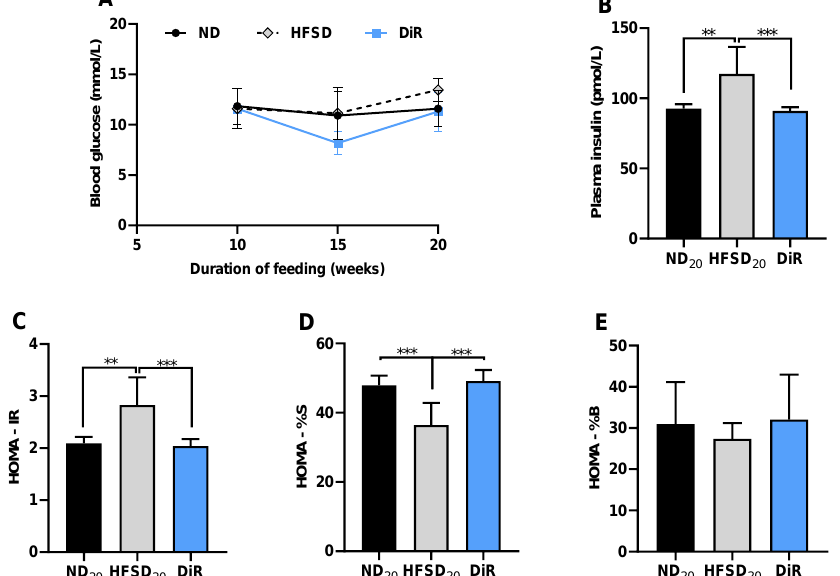
Figure 6. Diet reversal ameliorates dysregulated insulin sensitivity ( A ) Fasting blood glucose levels ( n ≥ 7 per group). ( B ) Plasma insulin levels, ( C ) Insulin resistance, ( D ) Insulin sensitivity, and ( E ) Beta cell function in mice fed only the normal diet, only the high-fat/sucrose diet, and the diet reversal mice ( n ≥ 7 per group). Data expressed as mean ± S.D. ND 20 —20-week normal diet; HFSD 20 —20-week high fat diet; DiR—diet reversal; ** p ≤ 0.01, *** p ≤